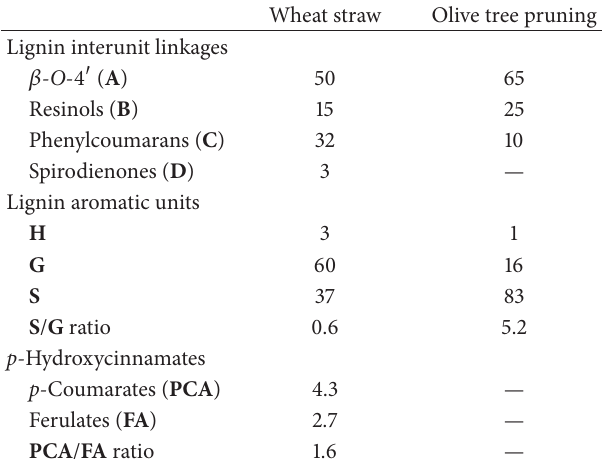
Table 3: Structural characteristic of lignin (main interunit linkages, aromatic units, S/G ratio, p -hydroxycinnamate content, and p - coumarate/ferulate ratio) from integration of 13 C– 1 H correlation peaks in the HSQC spectra of the fermentation residues from wheat straw and olive tree pruning WIS